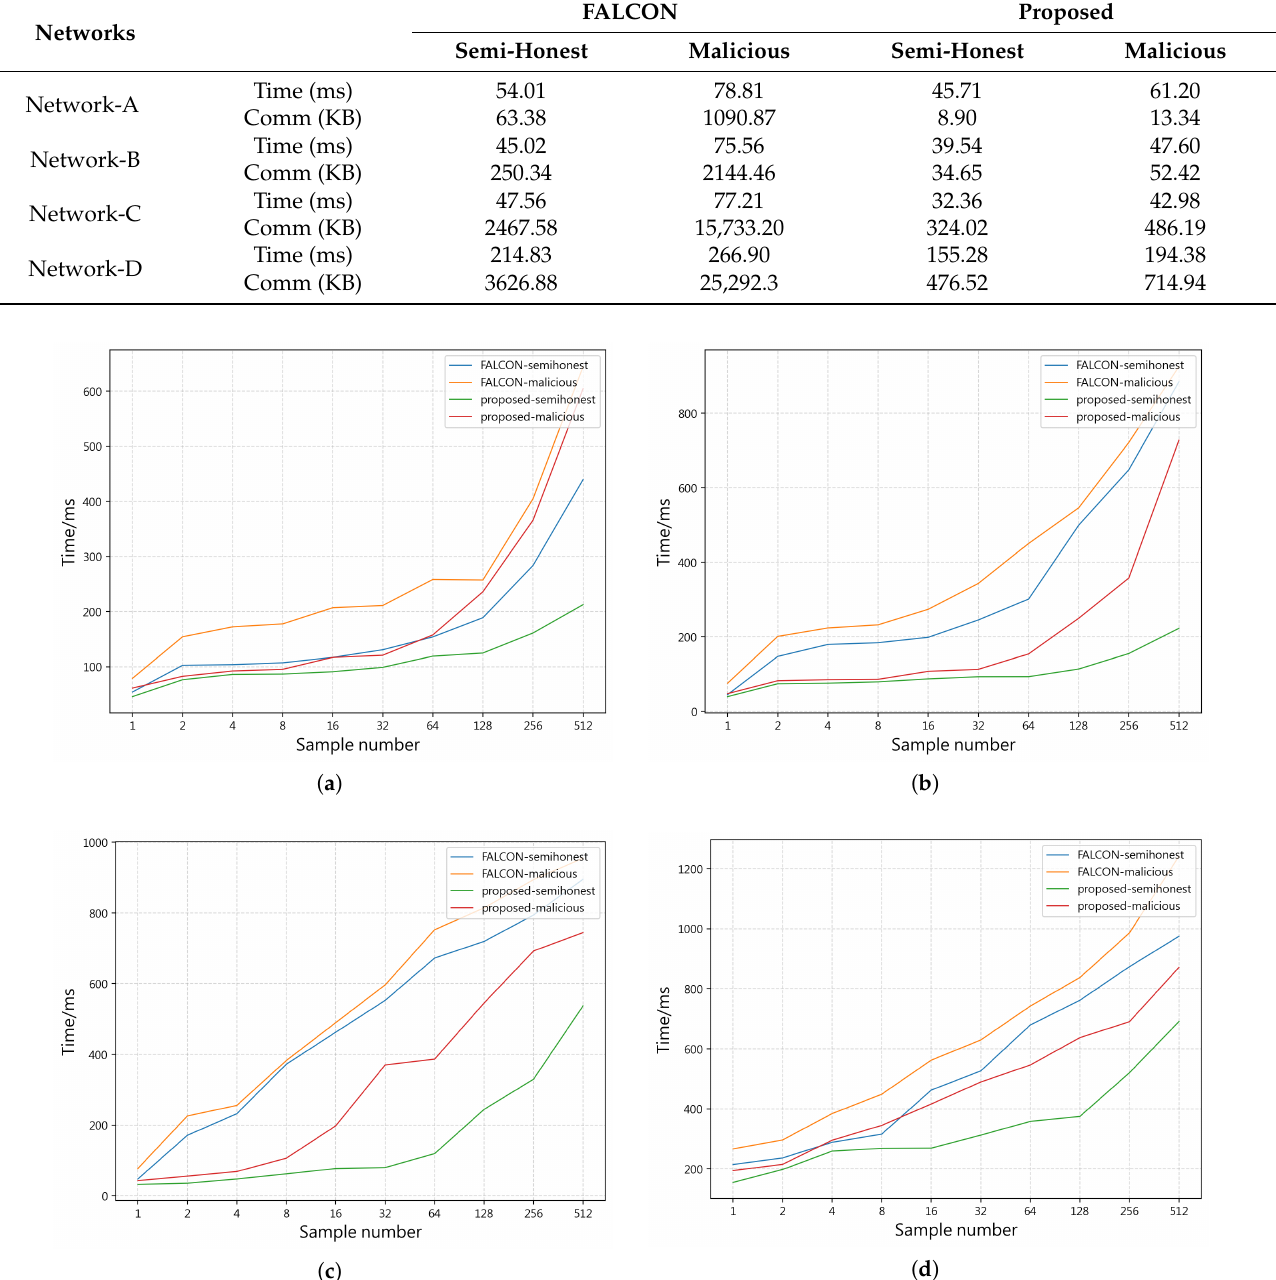
Table 5. Comparison of security predictions under different architectures.